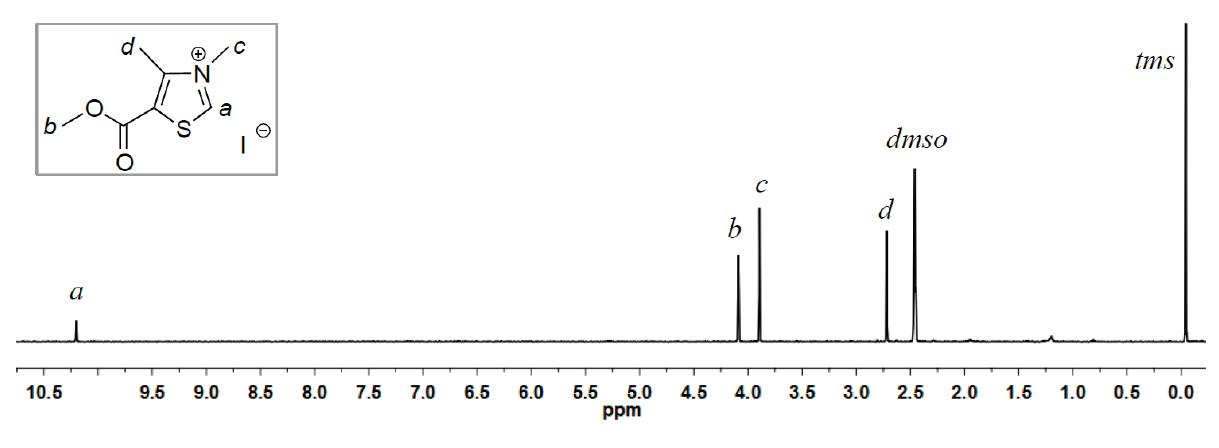
Figure 3. 1 H NMR (DMSO- d 6 ) of Ac [TM]I.